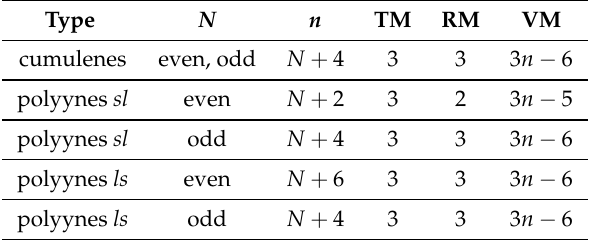
Table 2. n is the number of atoms, N is the number of carbon atoms. The number of modes, m = 3 n , from which three are translational modes (TM). Linear and nonlinear molecules have two and three rotational modes (RM), respectively; therefore, the number of vibrational modes (VM) is 3 n − 5 and 3 n − 6, respectively. Type N n TM RM VM